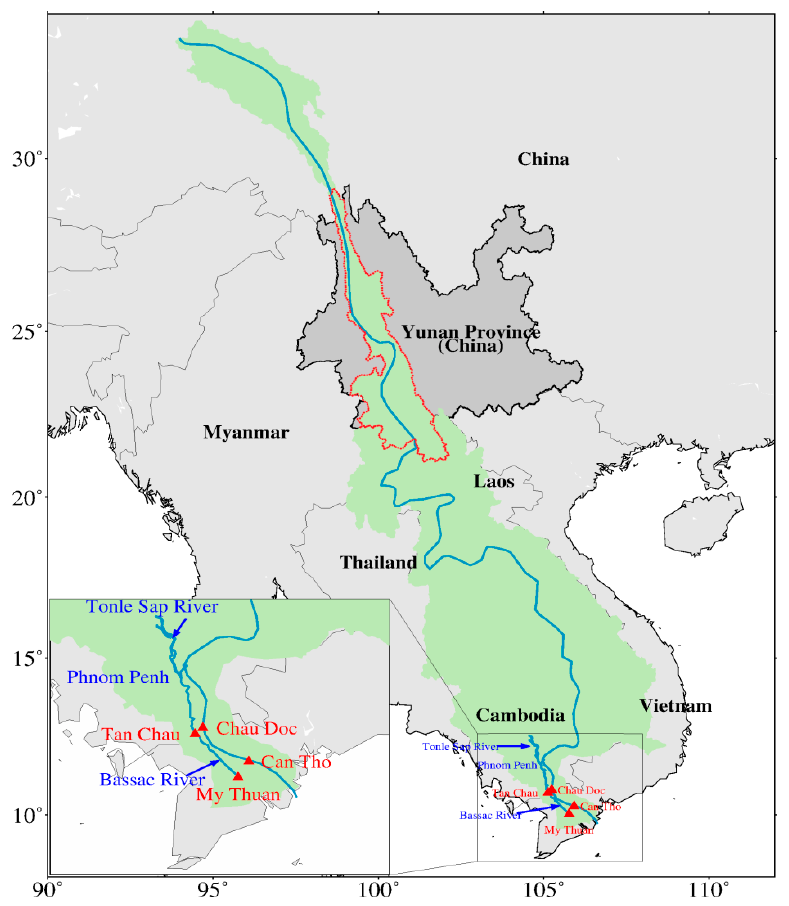
Figure 1. Map of the Mekong River Basin with two pairs of discharge gauge stations (My Thuan and Can Tho, and Tan Chau and Chau Doc) situated near the estuary mouth. Lancang River Basin boundary shown in red.